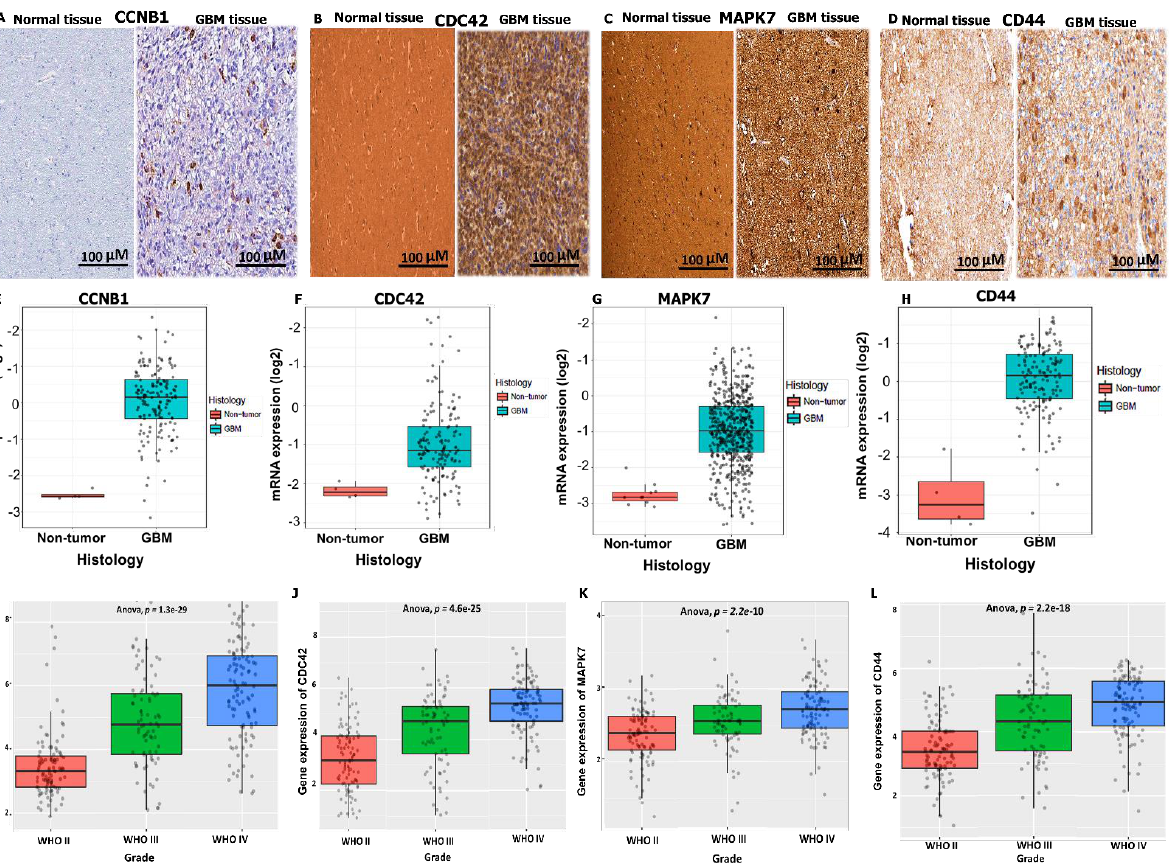
Figure 5. Increased expressions of CCNB1/CDC42/MAPK7/CD44 oncogenic signatures in glioblastoma. ( A ) CCNB1 displayed medium IHC staining, with strong intensity and quantity (25%). ( B ) CDC42 displayed medium IHC staining, with moderate intensity and quantity (75%). ( C , D ) MAPK7 and CD44 displayed high IHC staining with strong intensity and quantity (75%), in GBM tissues as compared to normal tissues. ( E – H ) Increased mRNA expression levels of CCNB1/CDC42/MAPK7/CD44 oncogenes in GBM tissues compared to non-tumor tissues from a GlioVis database analysis. ( I – L ) Expressions of CCNB1/CDC42/MAPK7/CD44 gene signatures in WHO grade II, III, and IV GBM tumors using the Analysis of variance (ANOVA), with p < 0.05 considered statistically significant in all datasets. All images can be found online.